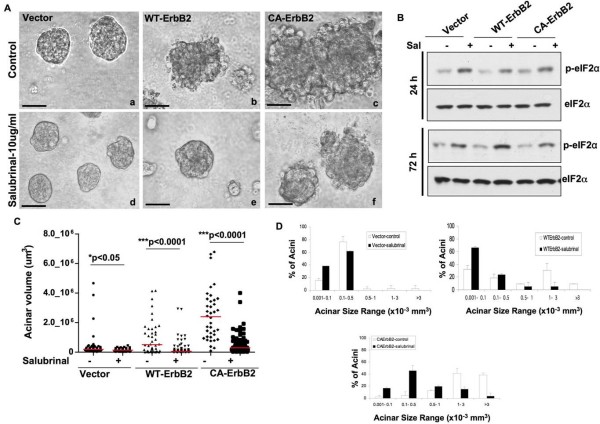
Salubrinal increases basal phospho-eIF2α levels and significantly limits ErbB2-induced acinar growth. (A) Phase-contrast micrographs of control and ErbB2-expressing acini untreated (top panels) or treated with salubrinal (10 μg/ml) from Day 4-day 10 in Matrigel (bottom panels). Note the reduced acinar size of salubrinal treated ErbB2-expressing acini. Scale bars = 60 μm. (B) Western blots showing the increase in phospho-eIF2α levels in empty vector, Wt-ErbB2 or CA-ErbB2 cells untreated or treated with salubrinal under adhered monolayer conditions for the indicated time points. Total eIF2α was used as loading control. (C) Acinar volume was quantified on day 8 in Matrigel after daily treatment with salubrinal (day 4 onwards) for vector, Wt-ErbB2 or CA-ErbB2 acini. Acinar volume was estimated by measure two perpendicular diameters per acinus, assuming an ellipsoid structure. Between 50-100 acini were quantified and results are representative of experiments repeated at least three times. Statistical significance was determined using the unpaired t-test with p < 0.05 defined as statistically significant. (D) Graphs showing the distribution of acinar sizes over several volume ranges to depict the increase in acinar size upon ErbB2 activation, mean ± SD. Note that salubrinal treatment causes a shift in the percentage of acini falling within the smaller size ranges.